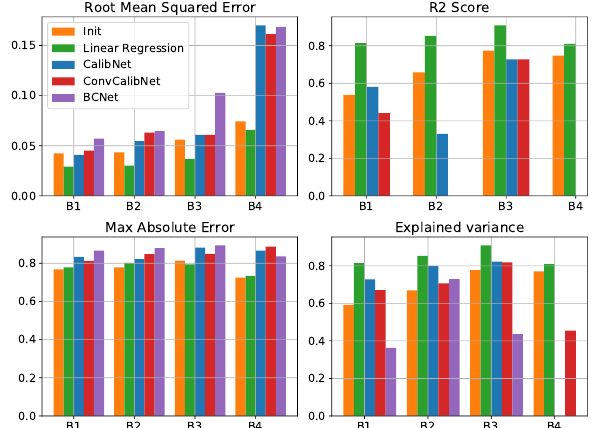
Figure 14. Comparisons of four standard metrics for the initial refletances and the four proposed methods measured on Bretagne2 dataset, where the Pleiades image is contaminated by unmasked clouds.